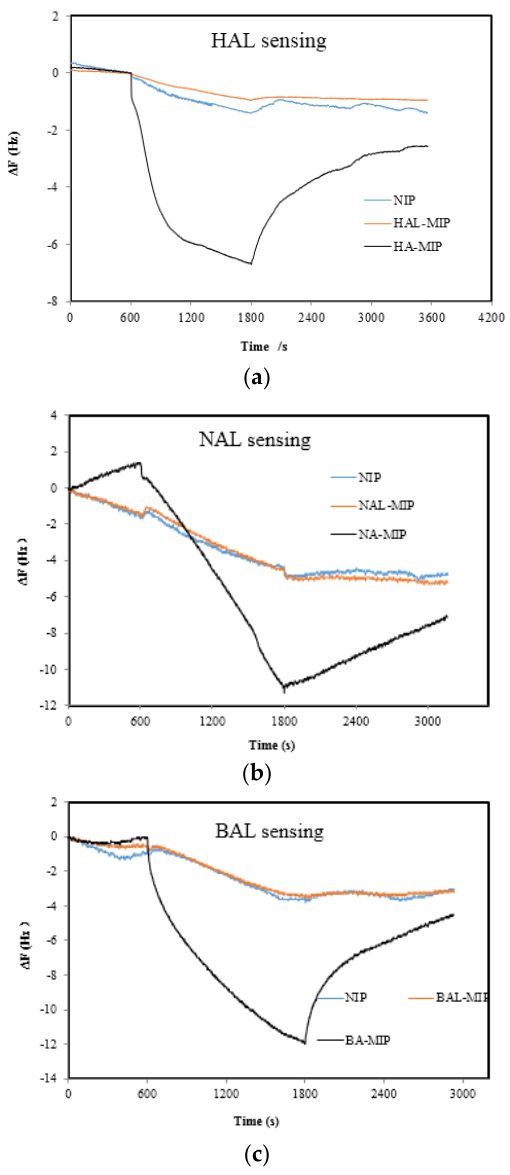
Figure 2. Response comparison of Ti-MISGs prepared by using aldehydes (Ald-) and corresponding organic acids (Acid-) as the templates: ( a ) hexanal and hexanoic acid; ( b ) nonanal and nonanoic acid; and ( c ) benzaldehyde and benzoic acid. The Ald-MIPs were prepared with the same conditions as S1, S2 and S3 except that the acid templates were replaced with aldehyde molecules.